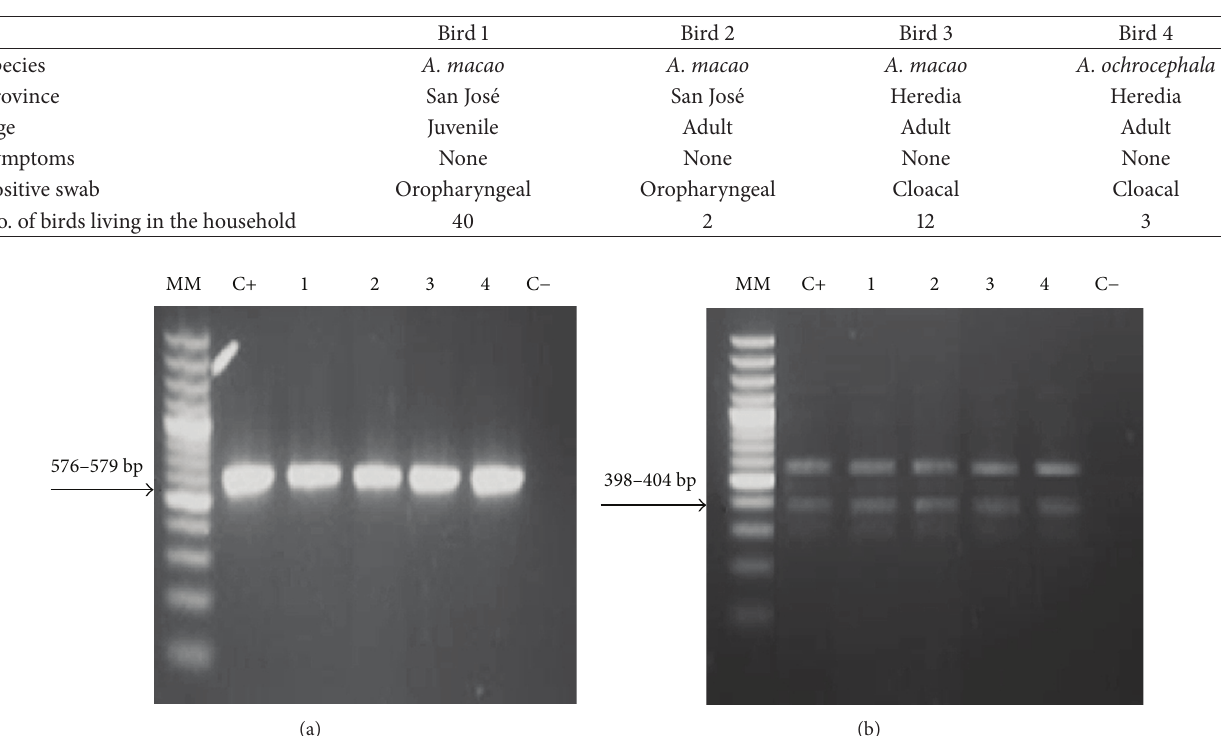
Figure 1: Gel electrophoresis of PCR products of Chlamydia spp. (a) and C. psittaci (b). (MM: molecular marker; C+: positive control; 1–4: Birds 1, 2, 3, and 4, positive to Chlamydia spp. and C. psittaci ; C − : negative